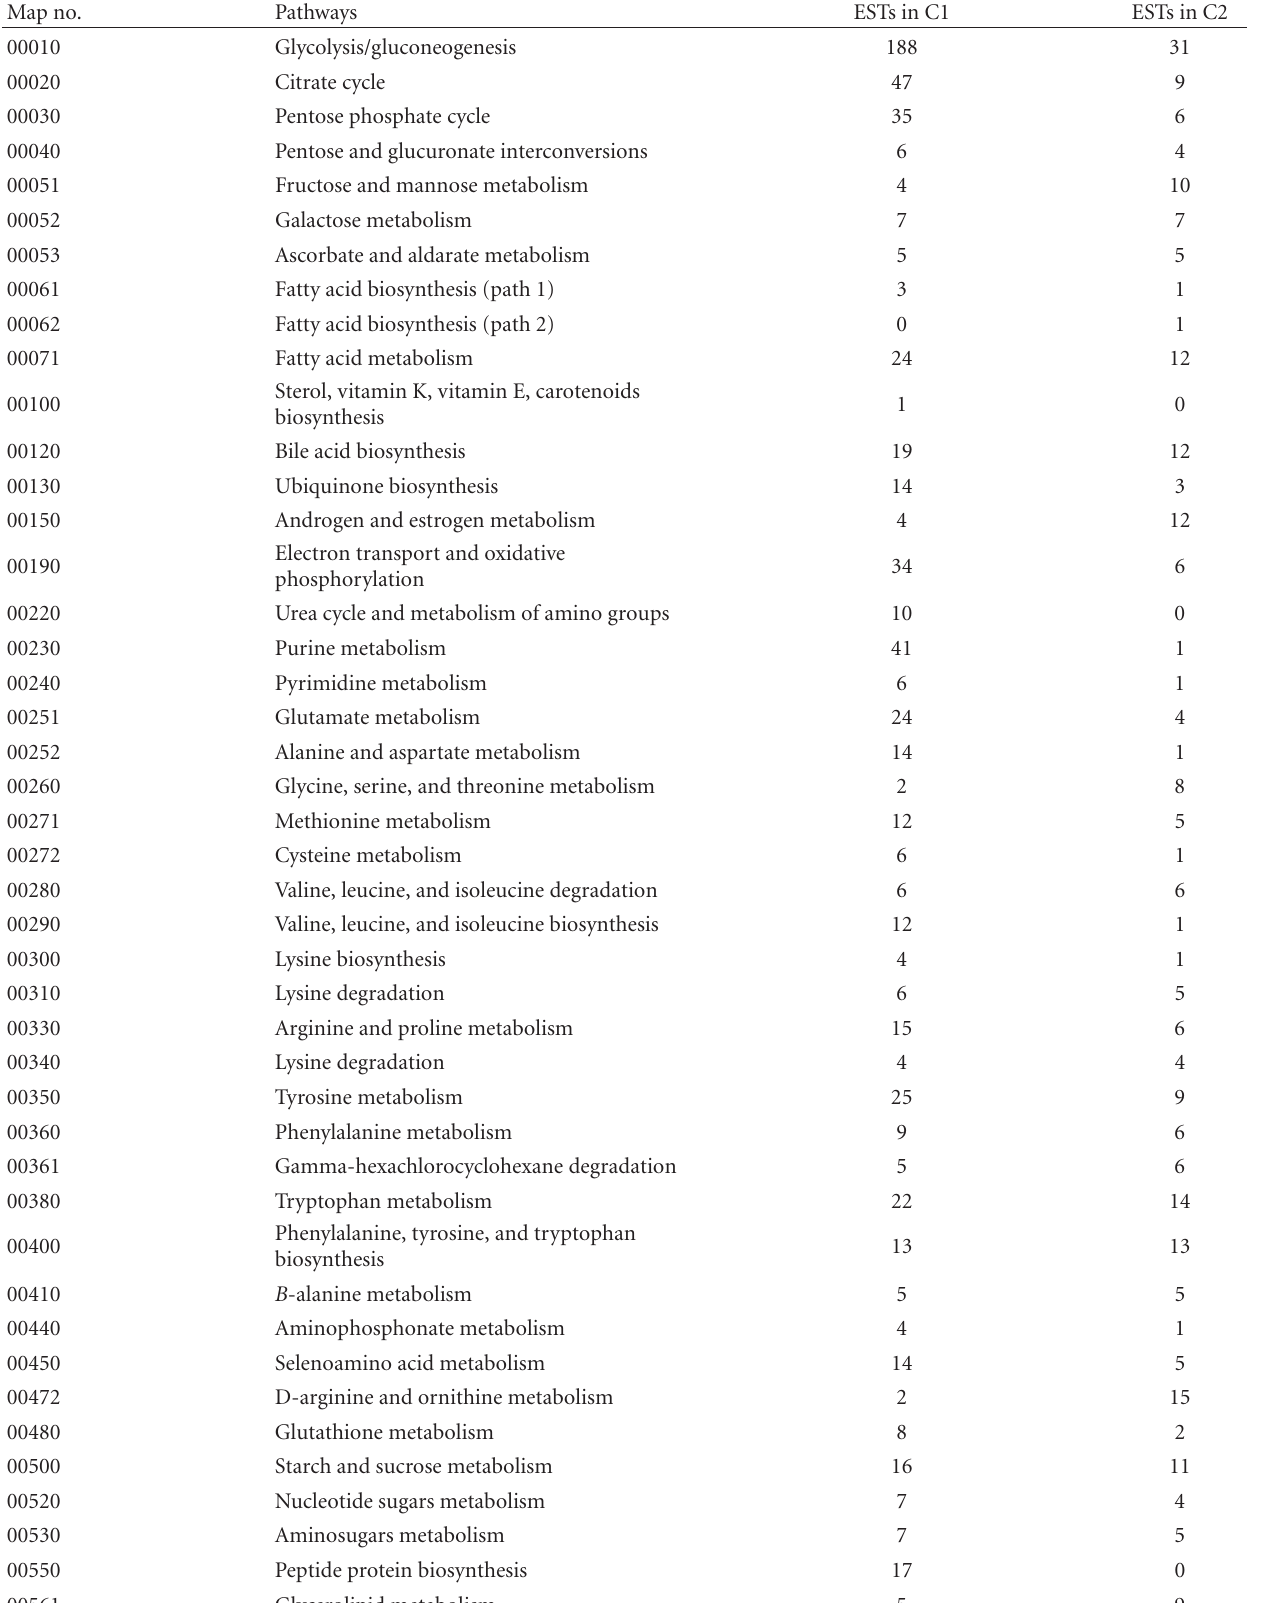
Table 2: The metabolic pathways di ff erence between cDNA libraries from C. cupreum